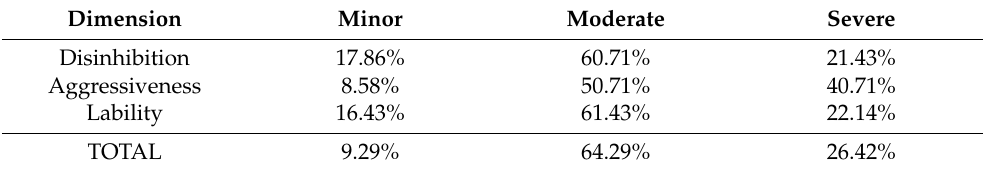
Table 3. Psychomotor agitation intensity.